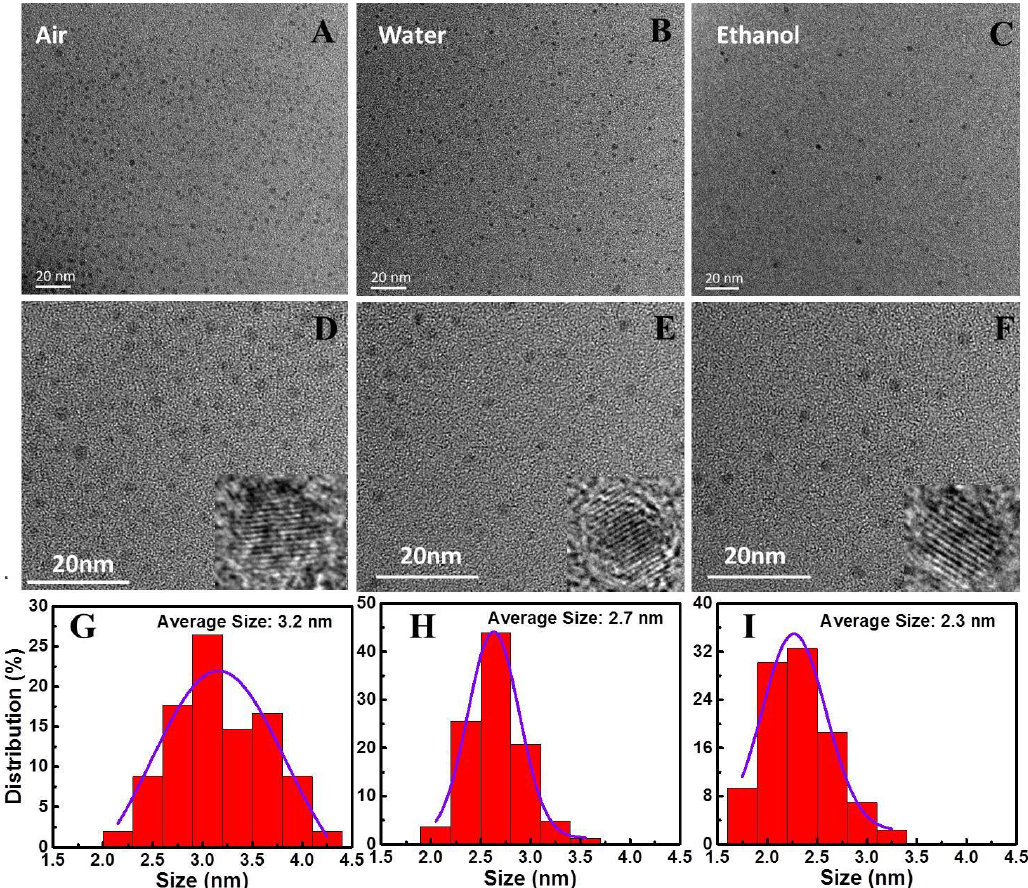
Figure 2. The transmission electron microscopy (TEM) images of GaN-NPs@air ( A , D ), GaN-NPs@water ( B , E ) and GaN-NPs@ethanol ( C , F ), the corresponding insets are their high-resolution TEM (HRTEM) images, and the corresponding size distribution are displayed in G, H and I, respectively.